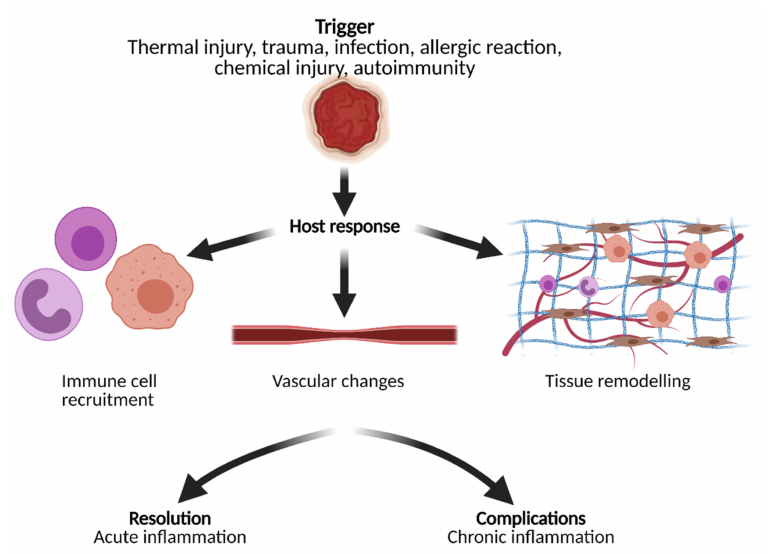
Figure 2. Inflammation is a multistep process triggered by a variety of causes and agents. This results in acute and/or chronic inflammation, which leads to host response in terms of cell recruitment, adap- tions of the vasculature, and changes of the tissue composition and extracellular matrix. All of these aspects pose possible targets for opto-/photoacoustic imaging. Figure created with